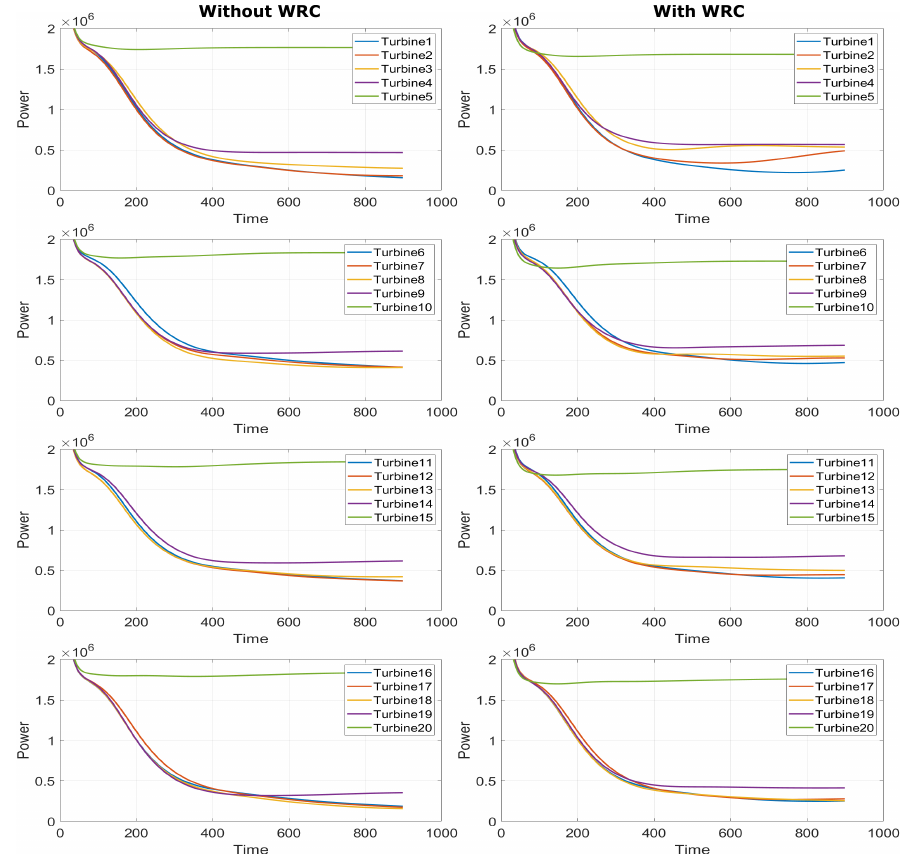
Figure 16. Time response of power produced by individual turbine with and without